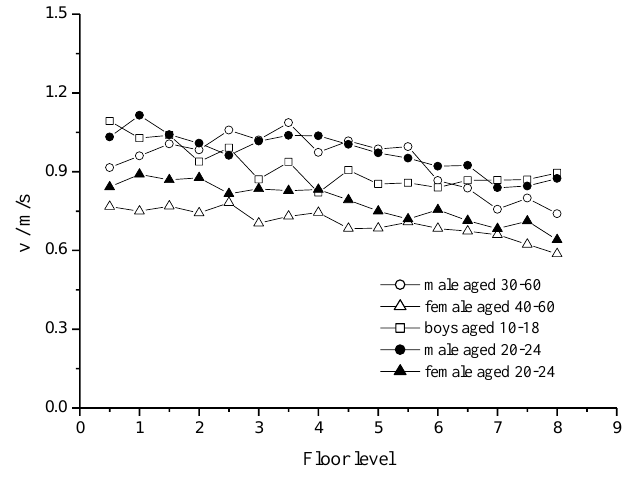
Figure 11. Comparison of the mean ascent speed of different age groups. Table 2. Summary of the mean ascent speed.